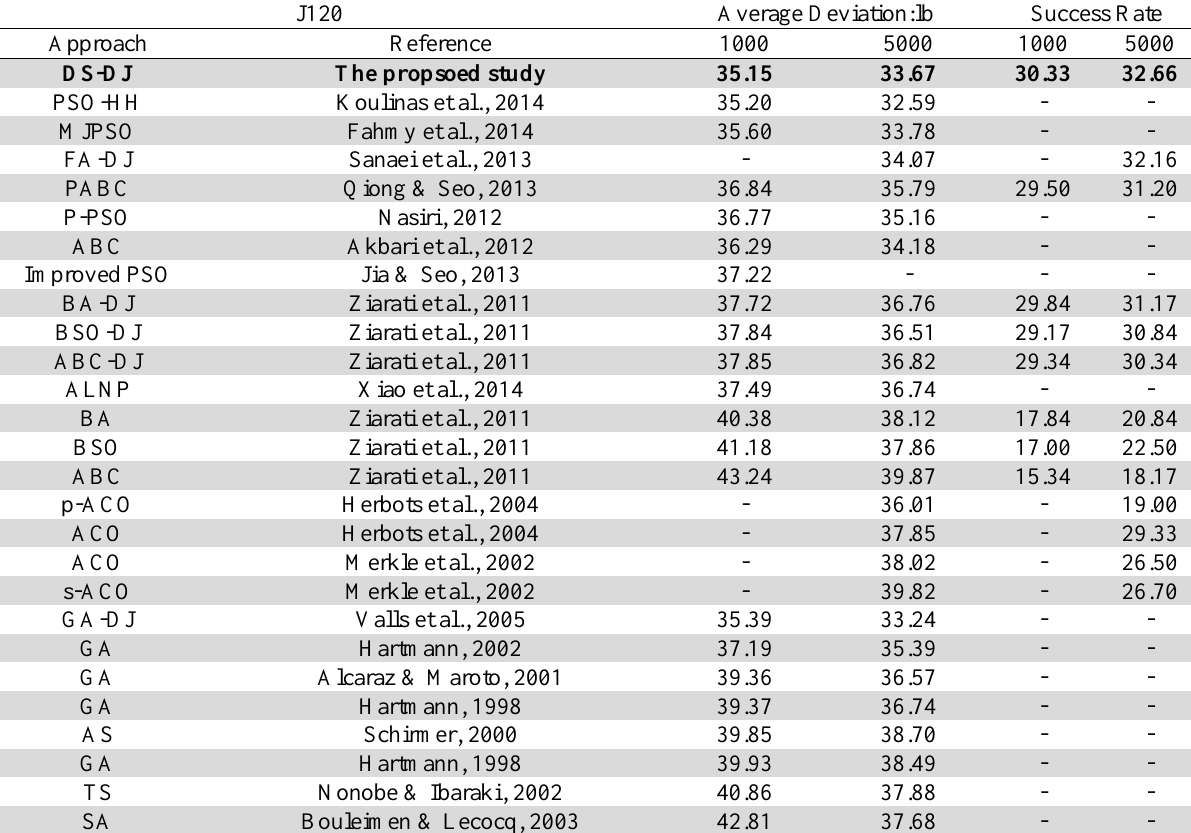
Table 5 Average deviation and success rates over J120